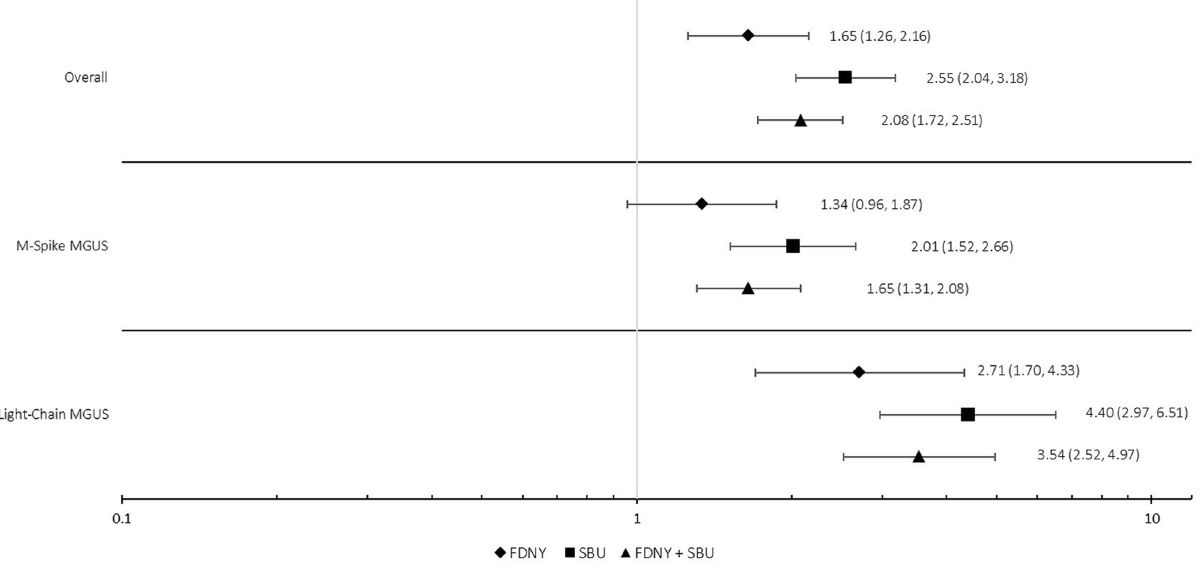
Fig. 1 Age standardized risk ratios among white, male participants, aged 50 – 79 compared with the comparison population from Olmsted County, MN, USA [17]. Reference is demographically similar Olmsted county male participants aged 50 – 79; all rates were fi rst age- standardized to the US 2000 population; diamonds represent FDNY participants, squares: SBU participants; triangles represent all World Trade Center exposed participants (FDNY and SBU-GRC); FDNY Fire Department of the City of New York, SBU-GRC Stony Brook University General Responder Cohort, MGUS Monoclonal Gammopathy of Undetermined Signi fi